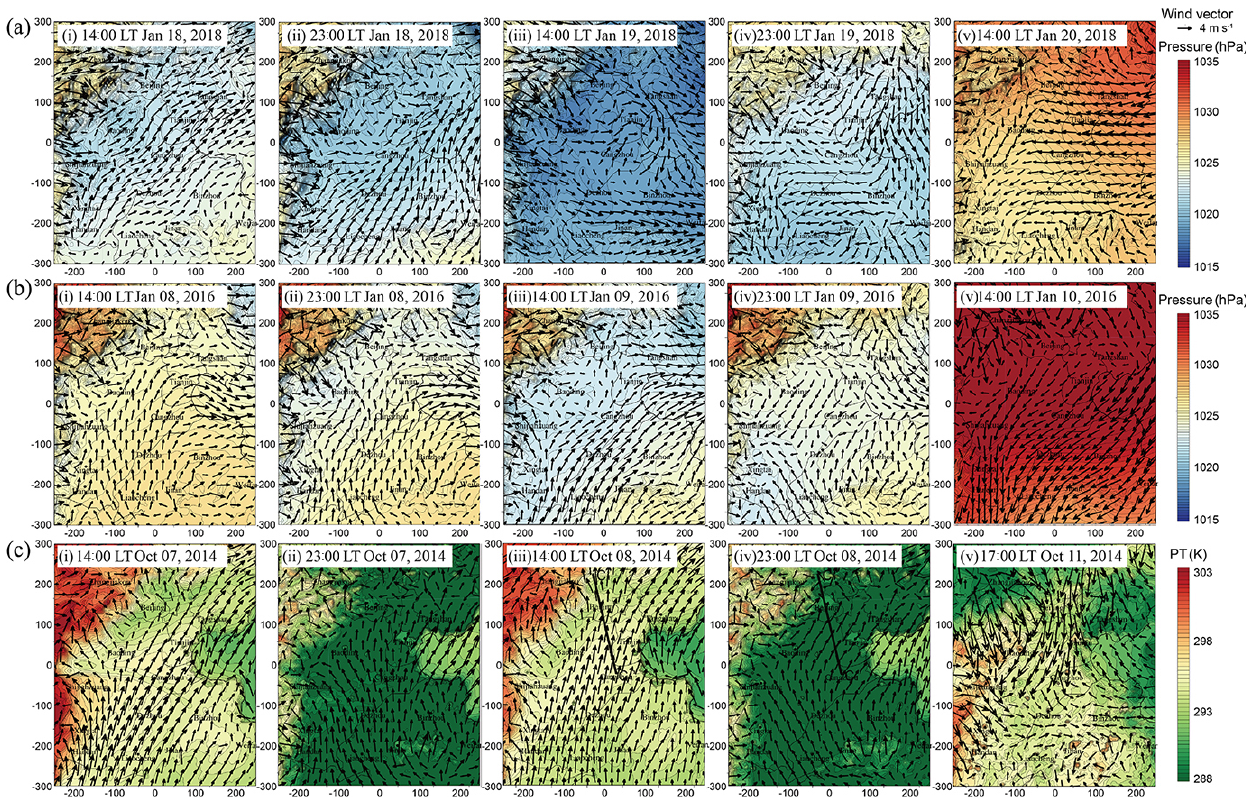
Figure 6. Simulated sea-level pressure/potential temperature and wind vectors at the pollution stages of (i) formation, (ii–iv) maintenance, and (v) diffusion during representative cases 1–3 under (a) west–southwest wind shear mode, (b) south–north wind shear mode, and (c) to- pographic obstruction category. The shaded colors represent the sea-level pressure in (a–b) and the surface potential temperature in (c) . The arrows indicate wind vectors. Values shown on x and y axes denote the distances (km) to the domain center. Lines C 1 C (cid:48) cross sections of the potential temperature in Fig.